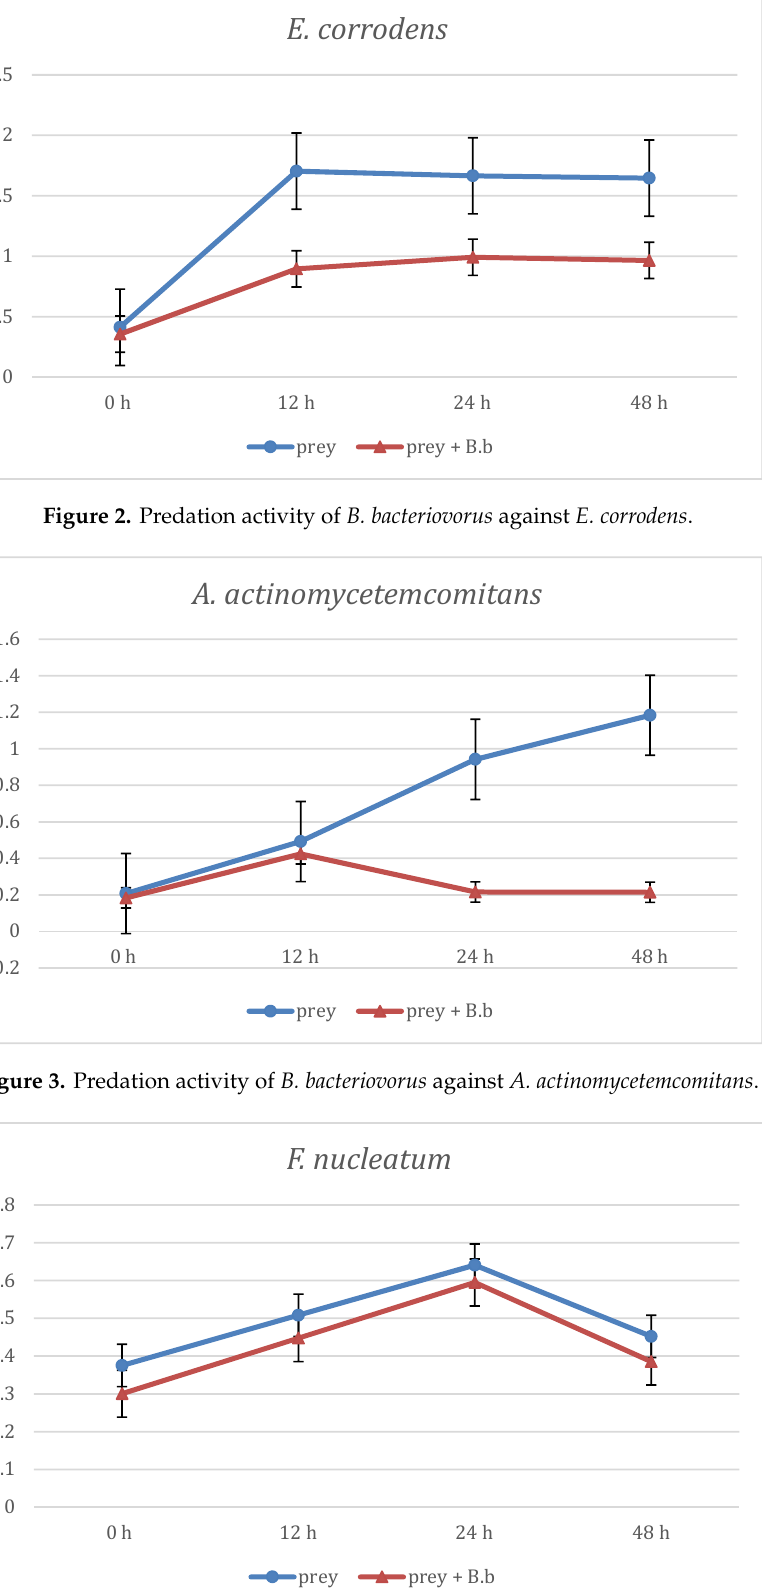
Figure 4. Predation activity of B. bacteriovorus against F. nucleatum .